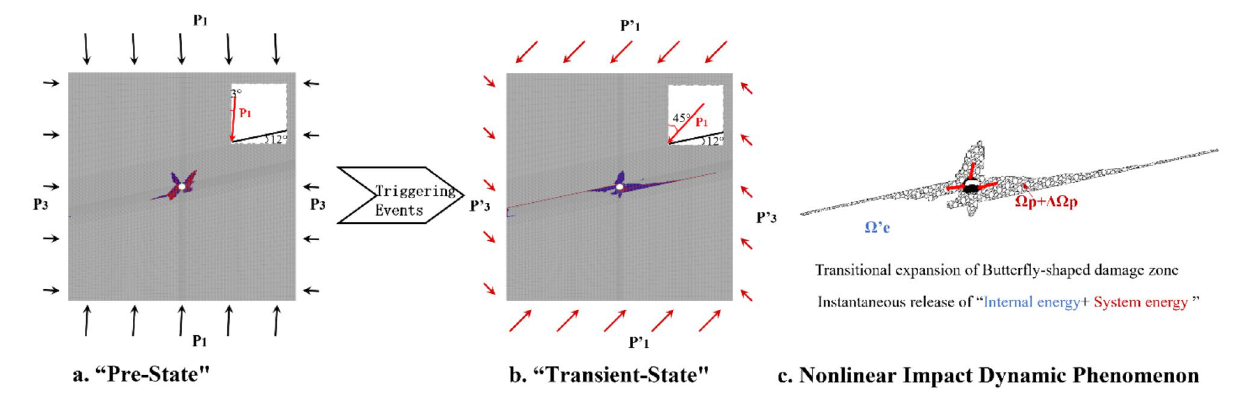
Fig. 11 Variation curve of Relative change maximum value of the plastic failure radius Δ R magnitude with working face distance